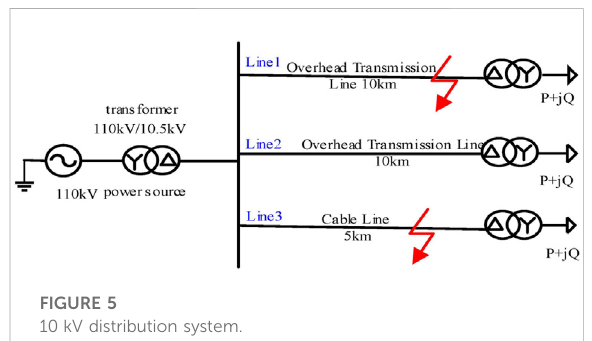
FIGURE 6 Output characteristic frequencyvoltage waveforms ofthree- phase